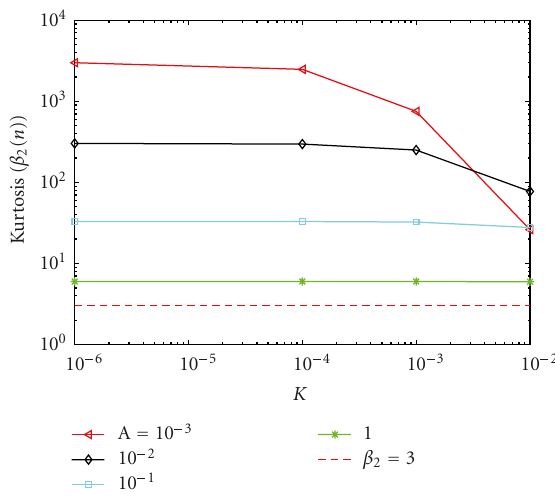
Figure 3: Excess kurtosis in Middleton class-A